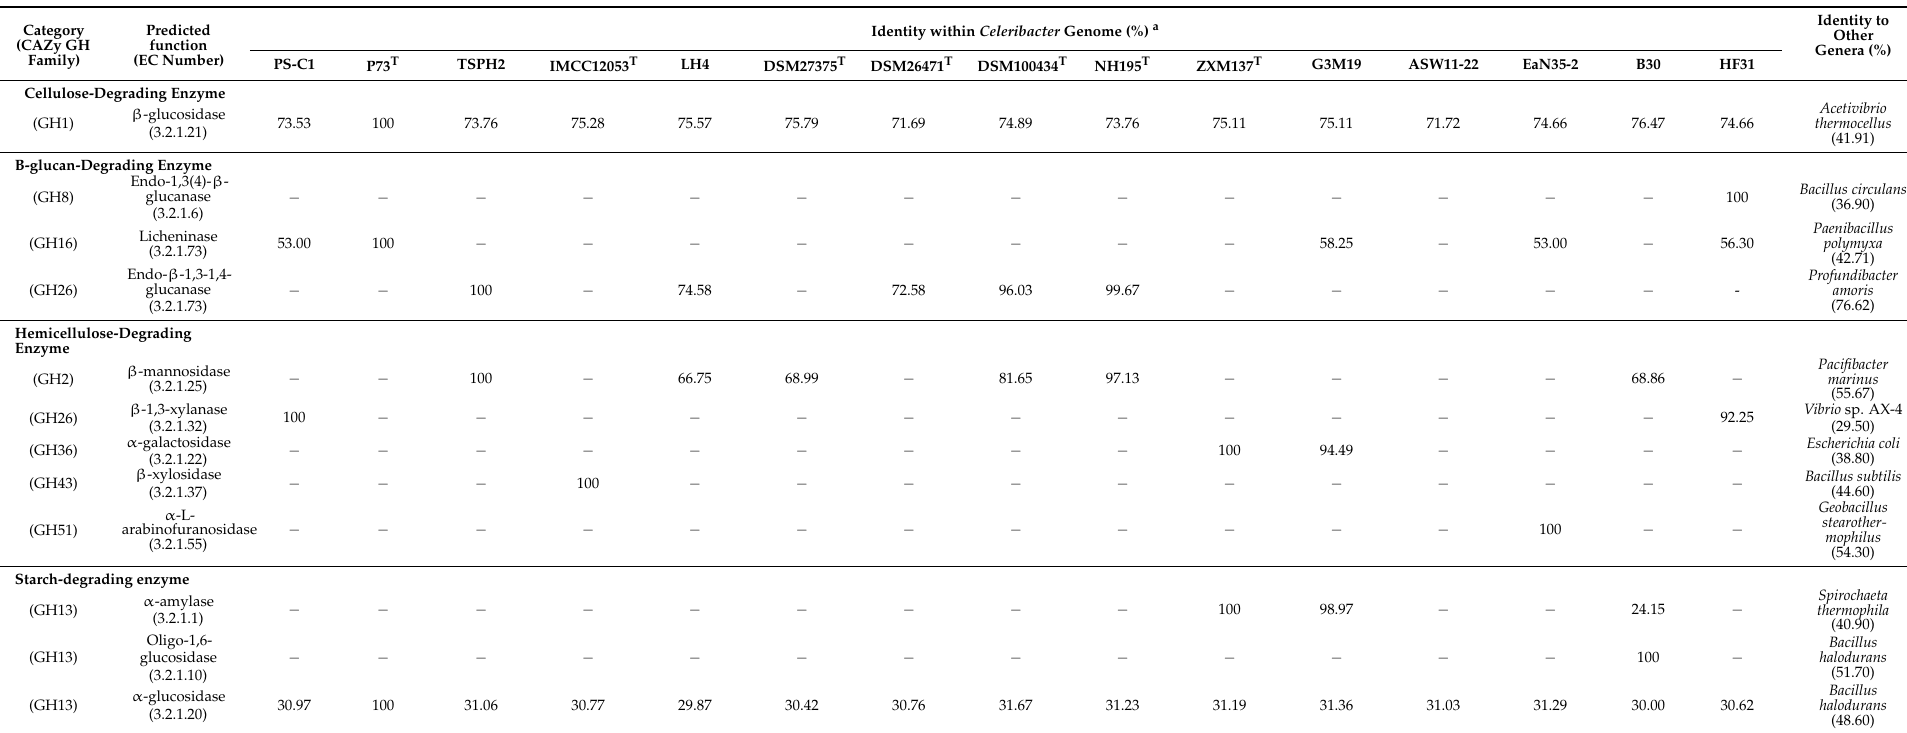
Table 5. List of several glycoside hydrolases (GHs) identified in Celeribacter genomes and their identity to the other genera.